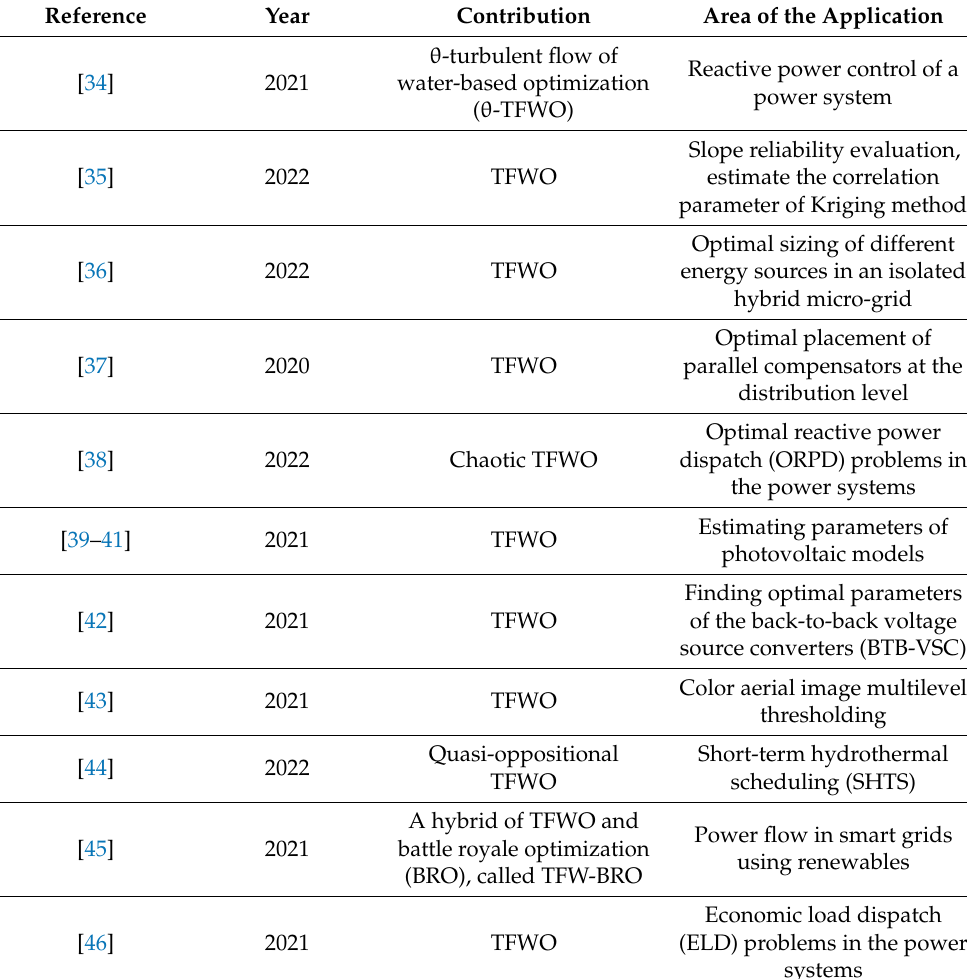
Table 2. Summary of some applications of the TFWO algorithm in the recent